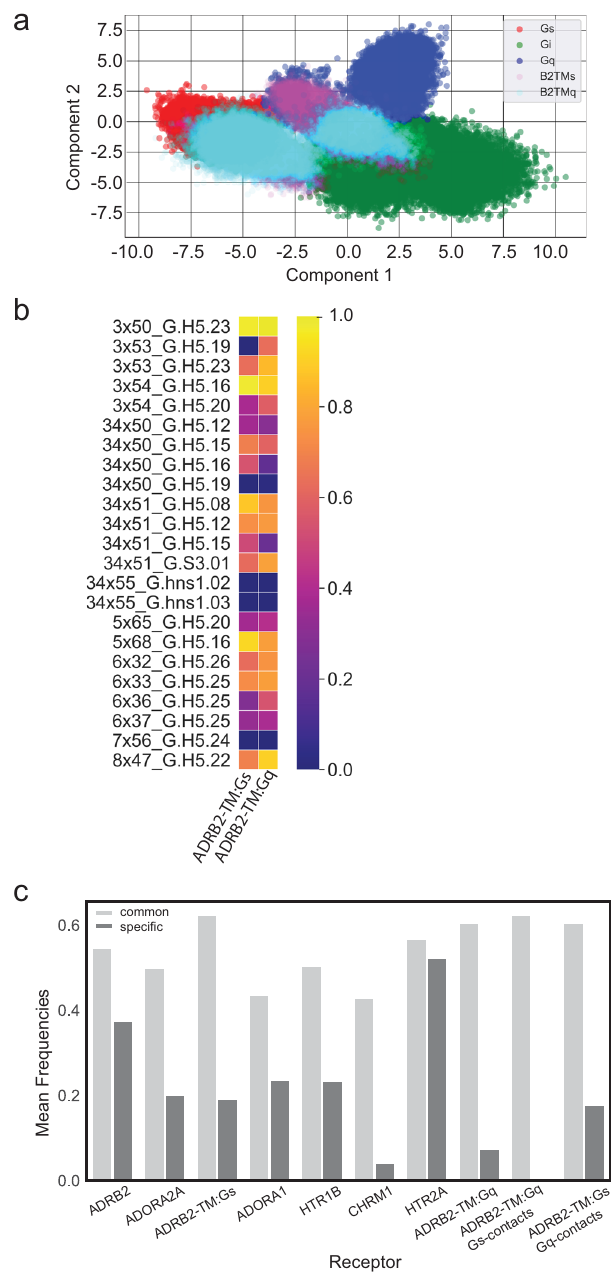
Fig.5|TheGPCR:GproteincontactlandscapeofpromiscuousGPCRs.a Analysis ofpromiscuousGPCRsintheframeworkoftheLDAmodeltrainedondatafromthe original six structurally resolved GPCR:G protein complexes. The promiscuous GPCR:G protein interactions are plotted using the feature weightings used to compute Component 1 and Component 2 from the LDA analysis performed in Fig. 4. The promiscuous GPCRs are distinguished by color and denoted in the legend: ADRB2-TM with Gs ( “ B2TMs ” , magenta), ADRB2-TM with Gq ( “ B2TMq ” , cyan).Theplottingofthesepromiscuousreceptorinteractionsliepredominantlyin the common space of the LDA model, suggesting the promiscuous receptor interactions with G proteins are represented by mostly non-distinguishing con- tacts. b Heatmap of contact frequencies for “ common contacts ” sampled in the promiscuous ADRB2-TM receptor. Source data are provided as Supplementary Data3. c ThepromiscuousGPCRsstudiedhereshowstrongersampling(measured by mean frequency per residue) within the subspace of “ common contacts ” pairs (light gray), and less frequent sampling of G protein family “ speci fi c contact ” pairs sampledwithin the G protein family to whichthey are coupled (medium gray).For the promiscuous ADRB2-TM, we calculated the mean frequency of subfamily spe- ci fi c contacts for the G protein-coupled within the simulation (ADRB2-TM:Gq, ADRB2-TM:Gs), and the mean frequency of subfamily speci fi c contacts for the opposite G protein family, while coupled to one of the G proteins (ADRB2-TM:Gq with Gs-contacts, ADRB2-TM:Gs with